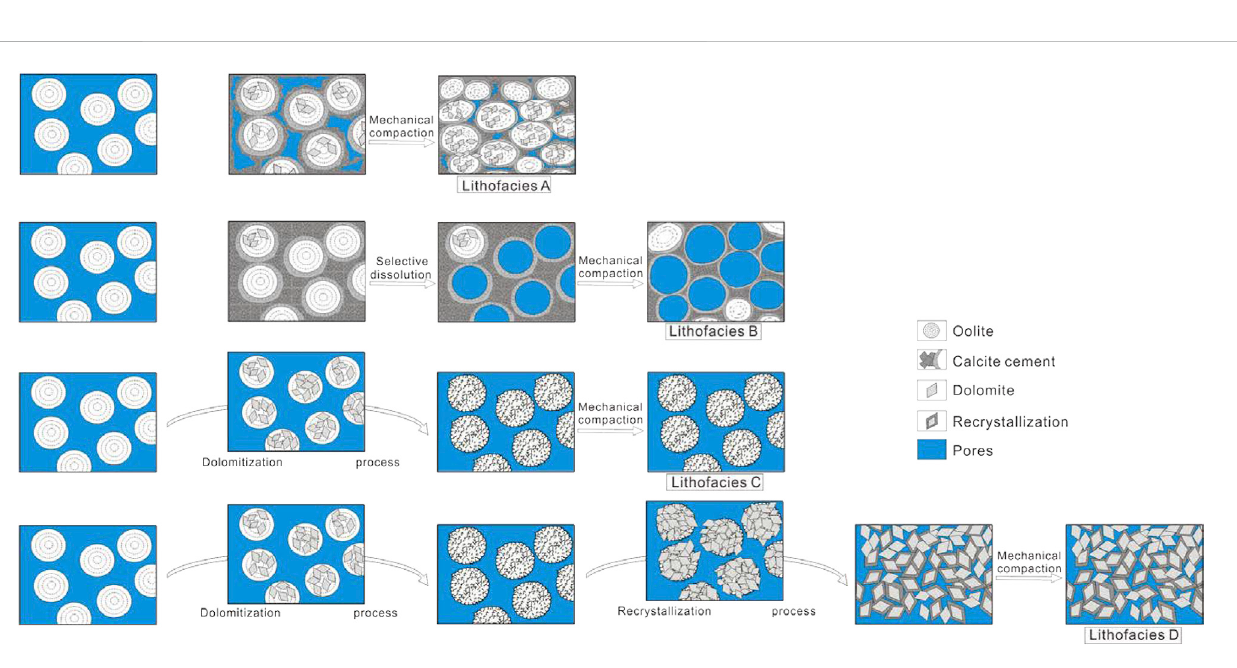
FIGURE 12 Diagenetic evolution of different lithofacies in Feixianguan Formation tight oolitic